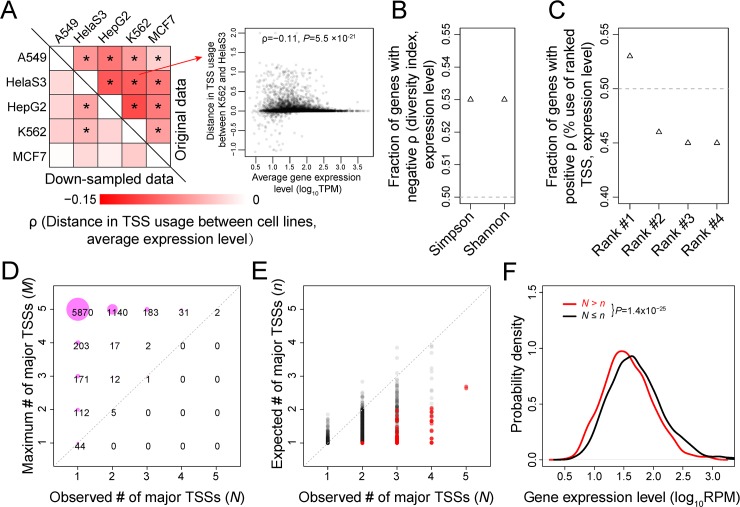
Variation in TSS usage among five human cell lines.(A) Spearman's correlations between the mean expression level of a gene in two cell lines and the between-cell–line distance in TSS usage. Above and below the diagonal are results obtained from the original and down-sampled data, respectively. All correlations are negative; those significant at P = 0.05 are indicated by an asterisk. The scatter plot for the comparison between K562 and HeLa S3 is presented as an example. (B) Fraction of genes with a negative among-cell–line Spearman's correlation between the Simpson or Shannon index of TSS diversity and expression level. (C) Fraction of genes with a positive among-cell–line Spearman's correlation between the gene expression level and fractional use of a ranked TSS. In (B) and (C), results are based on down-sampled data and P < 10−4 in all cases (binomial test). (D) The maximum number (M) of different major TSSs that a gene can have (given its observed TSSs) in the five human cell lines is greater than the observed number (N) of different major sites for almost all genes with M ≥ 2. The area of a circle is proportional to the indicated number of genes in the circle. (E) Only in a minority of human genes is the number (N) of observed major TSSs significantly greater than that (n) expected under no differential use of TSSs among five human cell lines. Each dot represents a gene, with red dots denote genes whose N exceeds n significantly (Q < 0.05). No gene has a significantly lower N than n (Q < 0.05). (F) The probability densities of expression level for genes with larger N than n (not necessarily significantly; red) and the rest of the genes (black). In this panel, N and n have been re-estimated using down-sampled data to equalize the sampling error among genes. Data are available at https://github.com/ZhixuanXu/Nonadaptive-alternative-TSSs. HepG2, human liver cancer cell line Hep G2; MCF7, human breast cancer cell line MCF-7; RPM, reads mapped to the gene per million reads; TSS, transcription start site.